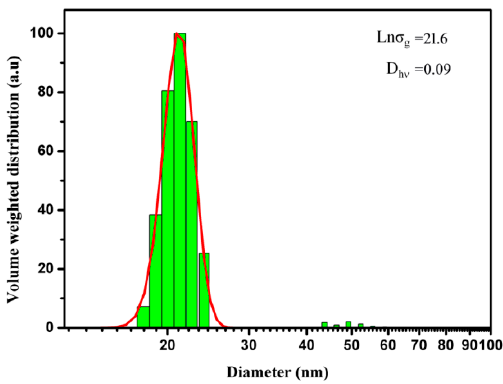
Figure 4. Hydrodynamic diameter of the Fe-Ni-B particles.